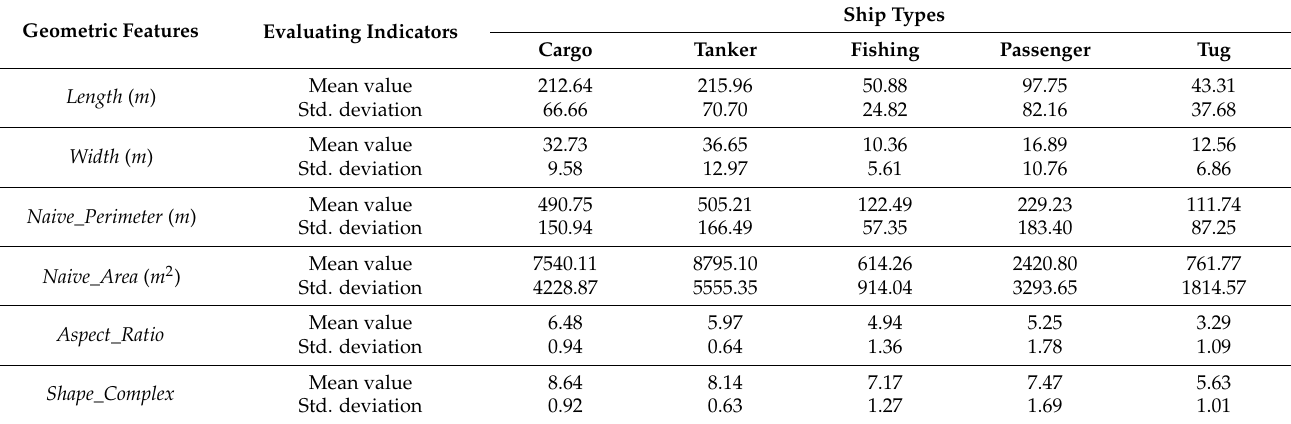
Table 3. The statistical results of ship geometric